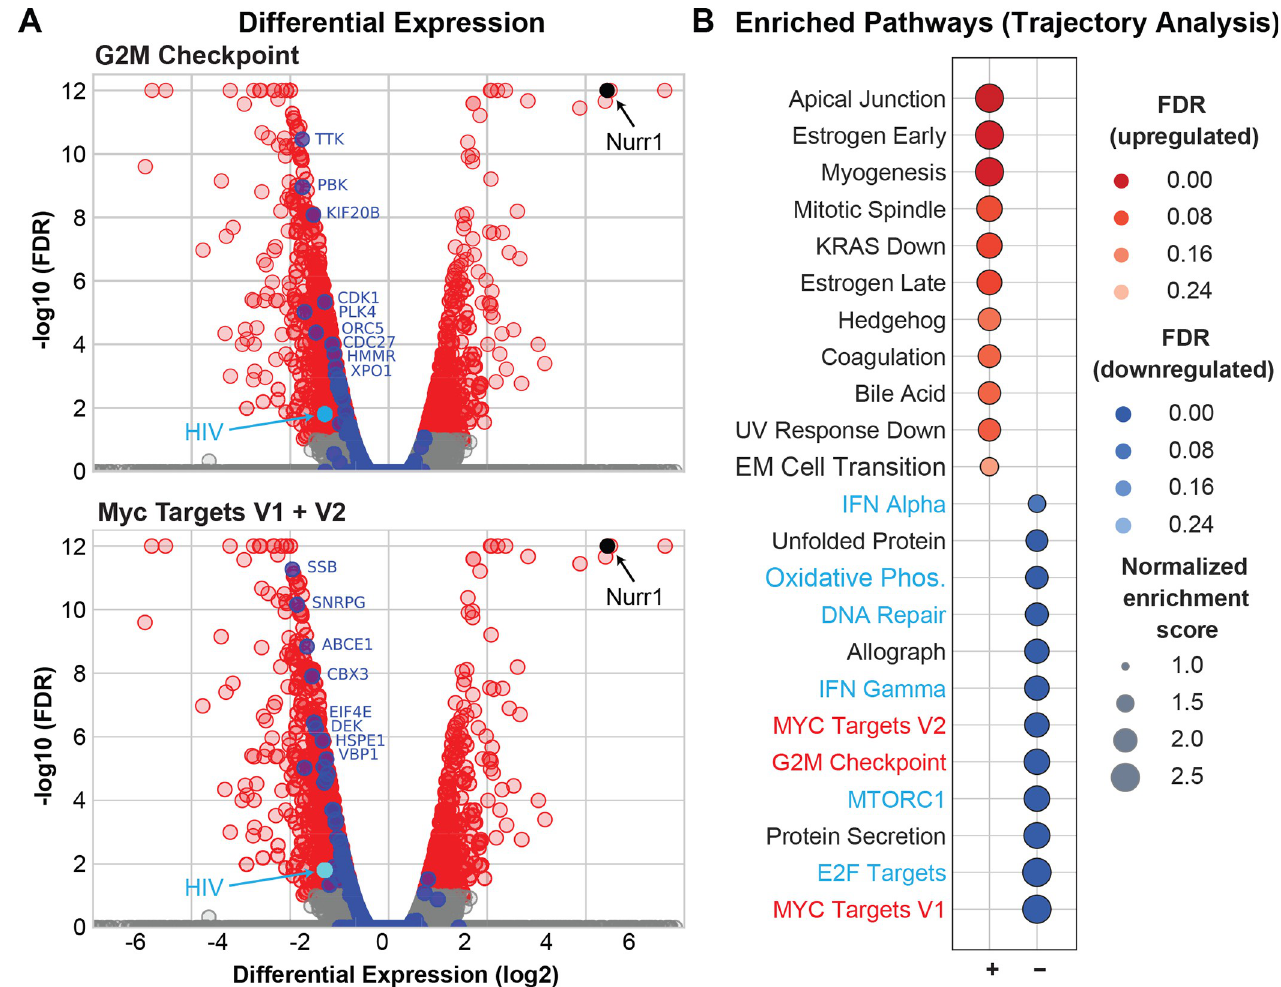
Fig 12. Identification of genes that are silenced due to Nurr1 overexpression. A . Volcano plots showing differential expressed genes during the chase step in Nurr1 overexpressing cells. The position of Nurr1 is shown in black. HIV is shown in light blue. Genes from the G2M Checkpoint (top) and Myc Target (Bottom) pathways are heighted in dark blue. Statistically non-significant genes are shown in grey. B . Pathway analysis of genes differentially expressed in Nurr1 overexpressing cells. The genes were selected based on Trajectory analyses. Pathways that are up regulated are shown in red. The color and size of circles correspond to statistical significance, as shown by FDR, and normalized enrichment values, respectively. Positive (red) and negatively (blue) enriched pathways are shown in the left and right plot, respectively.